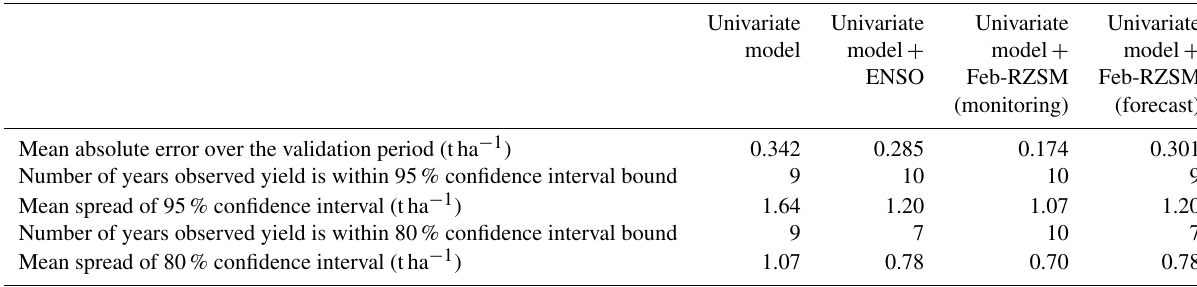
Table 1. Performance of “out-of-sample” crop yield forecasting over the validation period of 2008–2018.